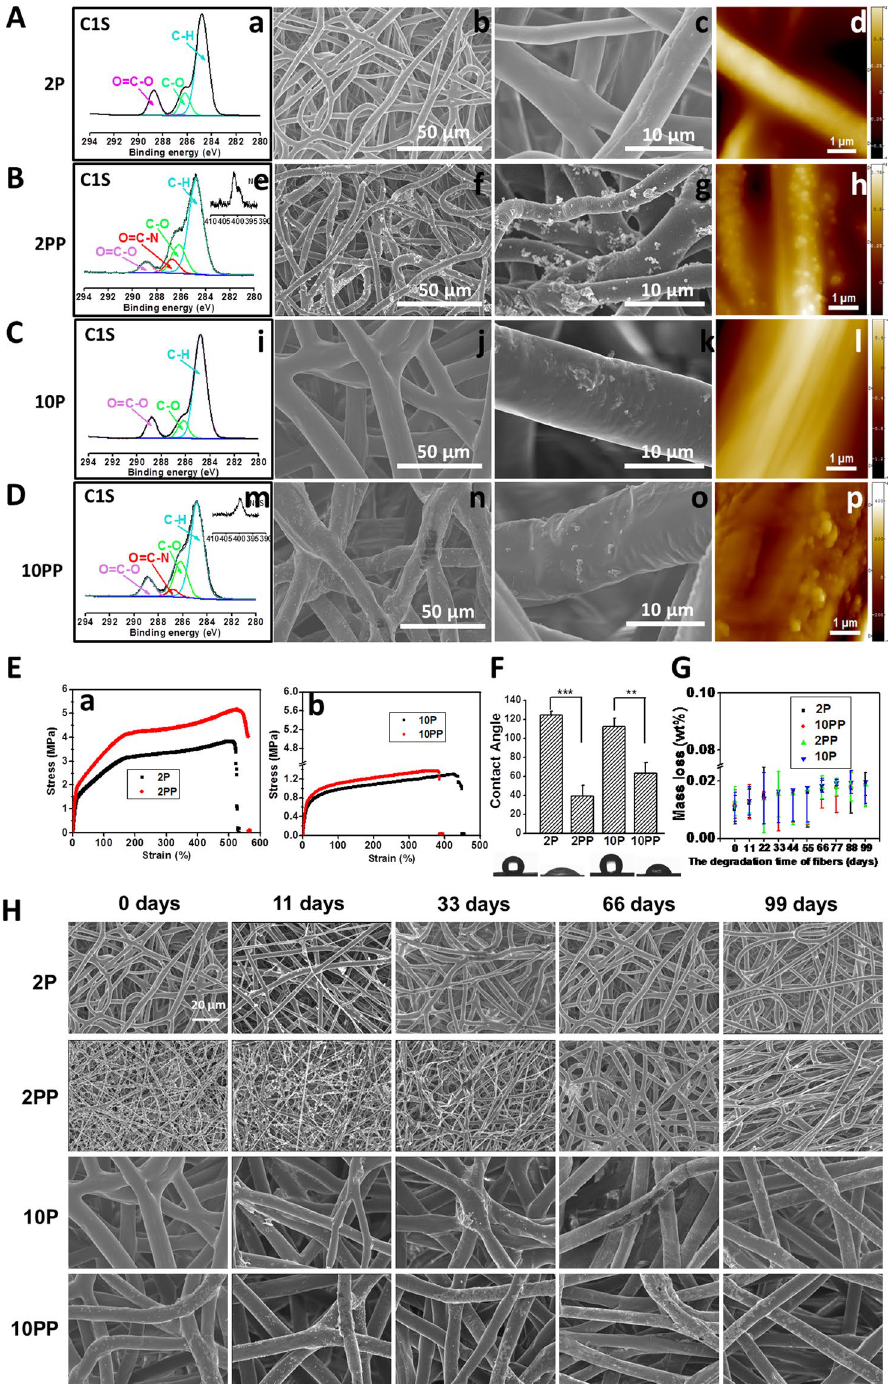
Figure 2. Characterization of PCL fibrous membranes. ( A – D ) XPS spectra (a,e,i,m), SEM (b,c,f,g,j,k,n,o) and AFM images (d,h,l,p). A, PCL fibrous membrane with 2 μ m in diameter (2 P). B, pNE coated PCL fibrous membrane with 2 μ m in diameter (2 PP). C, PCL fibrous membrane with 10 μ m in diameter (10 P). D, pNE coated PCL fibrous membrane with 10 μ m in diameter (10 PP). (E-H) The mechanical property, wettability and degradation in vitro of PCL fibrous membranes. E, The stress-strain curves of PCL fibrous membranes. F, Images and quantitative statistics of contact angle. G, Mass loss of PCL fibrous membranes after cultured in PBS at 37 °C for 11, 33, 66 and 99 days, respectively. H, SEM images of PCL fibrous membranes after cultured in PBS at 37 °C for 11, 33, 66 and 99